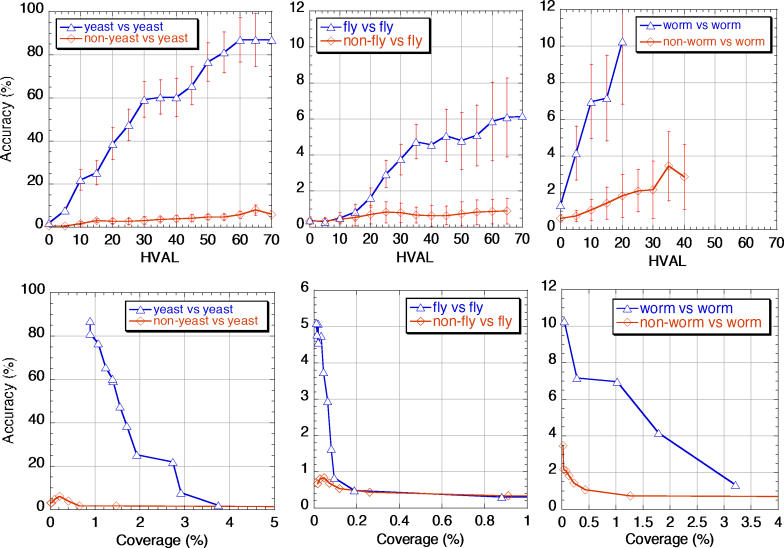
Performance of Homology TransferPlots compiled for experiments 2–7 in Table 4. Each of the upper three graphs stands for one particular organism o and shows two plots: (1) Use all known PPIs (large-scale and small-scale) of organism o to find Y2H large-scale detected PPIs in the same organism (but from different experiment, blue line). (2) Use all PPIs (large-scale and small-scale) of all other organisms (not o) to find PPIs detected by Y2H in o (red line). Only organisms with available Y2H datasets in IntAct were chosen in order to be able to create complete interaction matrices for the target datasets (yeast, worm, and fruit fly). All error bars were calculated through bootstrapping over the source PPIs (100 times, Methods). Some lines end at certain thresholds because the counts for true positives and false positives were too low (< 30 true or false positives) to calculate accuracy (Equation 4, see Materials and Methods, often also referred to as specificity or precision). Figure S1 shows the correlation between the size of the error bars and the counts of true positives at each HSSP-value cutoff. The three bottom plots show ROC-like curves, where accuracy is plotted versus coverage for the exact same data as for the three upper plots. The figures demonstrate that for all levels of similarity, the accuracy of intraspecies predictions of PPIs is significantly higher than for predictions across two organisms.